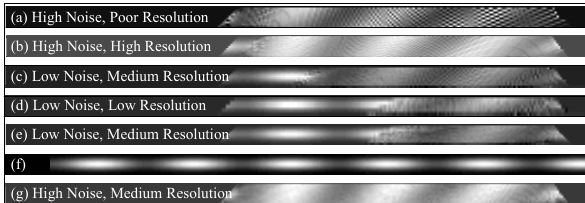
Figure 13. SVD and MAP reconstructions of the test example with various numbers of Fig. 13. SVD and MAP reconstructions of the test example with TEC data samples and changes in the sizes of the reconstruction cells. The original model layer (f) is given for reference. The samples per receiver vary from (a) 106 to (b various numbers of TEC data samples and changes in the sizes of through d) 541 to (e and g) 1082. The horizontal grid cell size is fixed at 1 km. The the reconstruction cells. The original model layer (f) is given for ref- vertical grid size varies from (b) ½ km to (a, c, e, and g) 1 km to (d) 2 km. The erence. The samples per receiver vary from (a) 106 to ( (b) through reconstruction techniques are (a through e) SVD and (g) MAP. The best reconstruction (e) matches the original (f) on the left half of the reconstruction region. (d) ) 541 to ( (e) and (g) ) 1082. The horizontal grid cell size is fixed at 1km. The vertical grid size varies from (b) 1/2km to (a, (c) , Even with the optimum parameters, the electron density reconstructions were only adequate for the left half of the data set. Figure 14 illustrates the best reconstruction of e, and g) 1km to (d) 2km. The reconstruction techniques are (a the test data set relative to the measurement geometry. The noisy region is the result of through e) SVD and (g) MAP. The best reconstruction (e) matches truly independent sampling of the downrange TEC with the two receivers to the left of the launch point (B). Because of nearly parallel propagation paths for horizontal ranges the original (f) on the left half of the reconstruction region. past 150 km, the reconstruction was repeated with the additional data from a receiver (C) located at the 150 km range point. The addition of the third receiver data greatly improves the reconstruction over the whole layer underneath the trajectory (Figure 15) because greater angles are obtained for the beacon to receiver paths. Future electron density imaging experiments would benefit from having at least one receiver located both SVD and MAP techniques were used for the algorithm directly underneath the apogee of the rocket. tests. Fig. 13 shows the results of the reconstructions with the algorithms. The MAP produced poor results. The SVD yielded excellent results for part of the reconstruction region. Using 106 samples gave high noise and poor resolution.